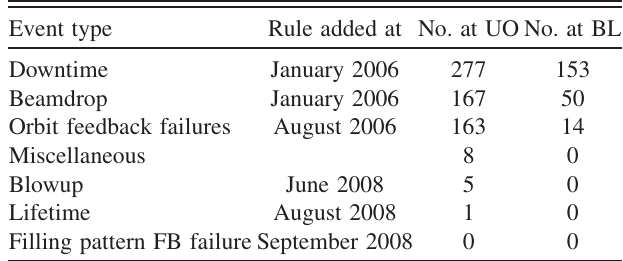
TABLE IX. Statistics of the recorded events at the SLS.